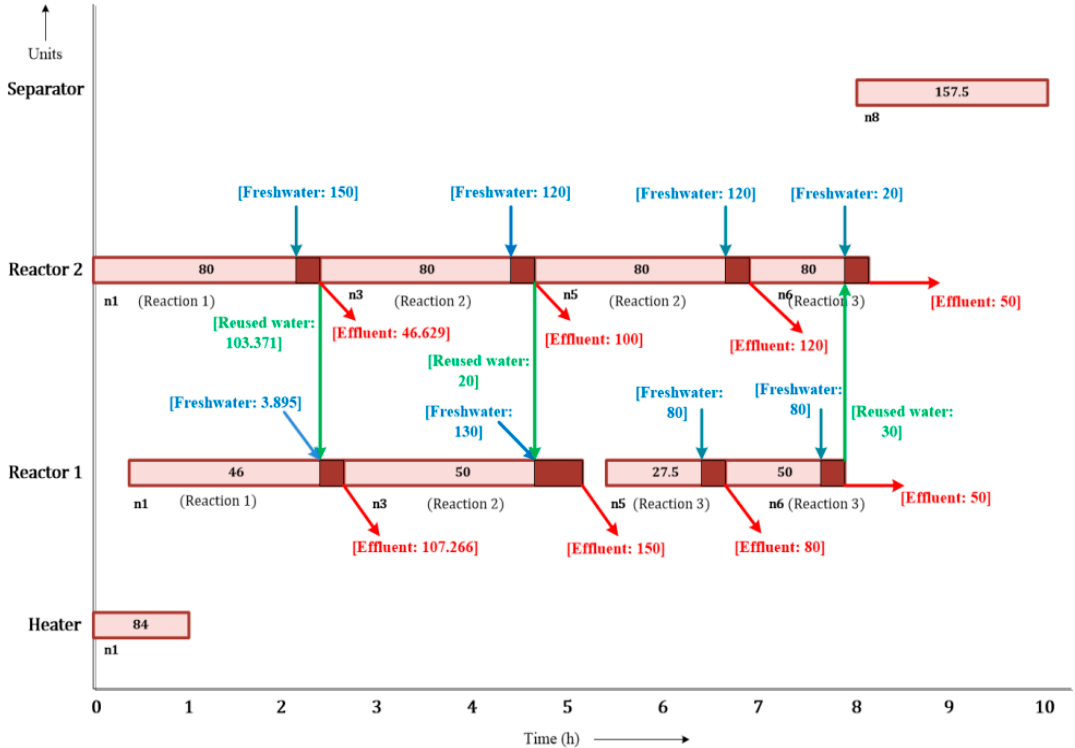
Figure 10. Gantt chart for the simultaneous approach for case study 2.